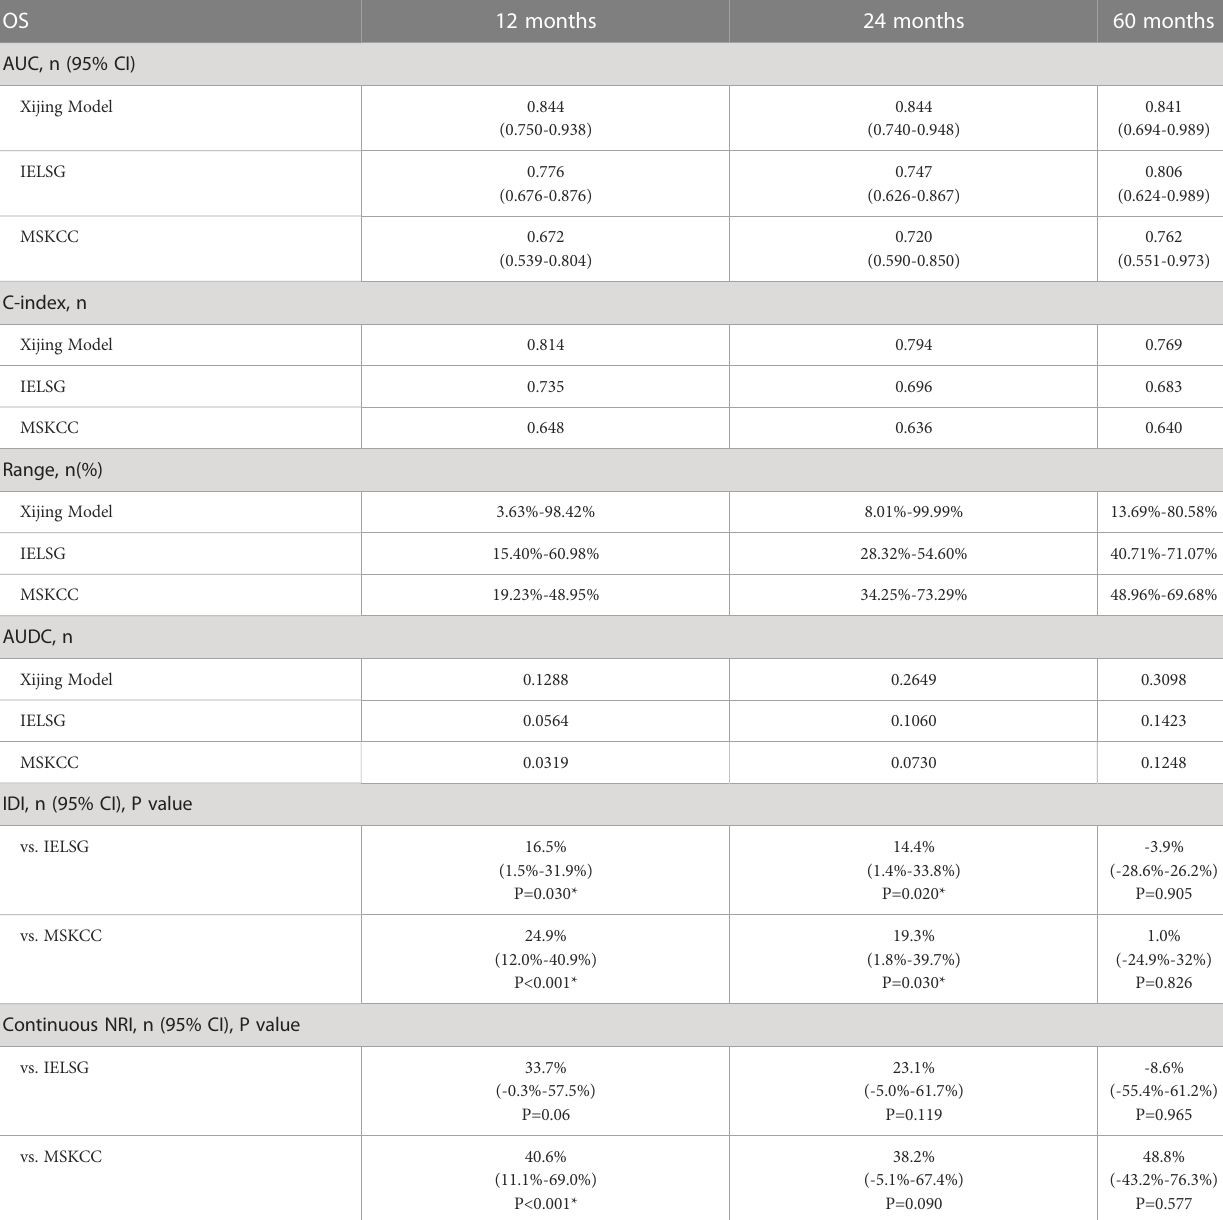
TABLE 4 Comprehensive evaluations of different models in the development